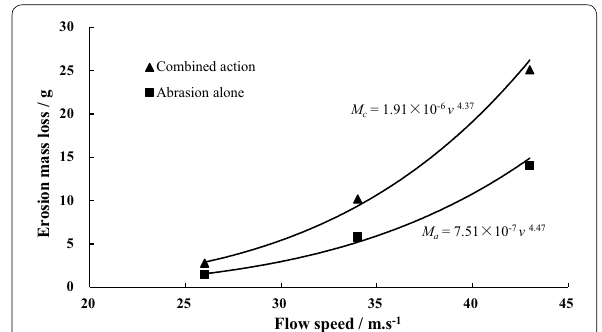
Fig. 11 Relationship between erosion and flow speed.